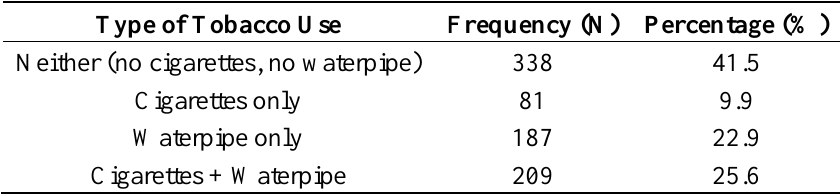
Table 5. Type of ―ever‖ tobacco use among participating